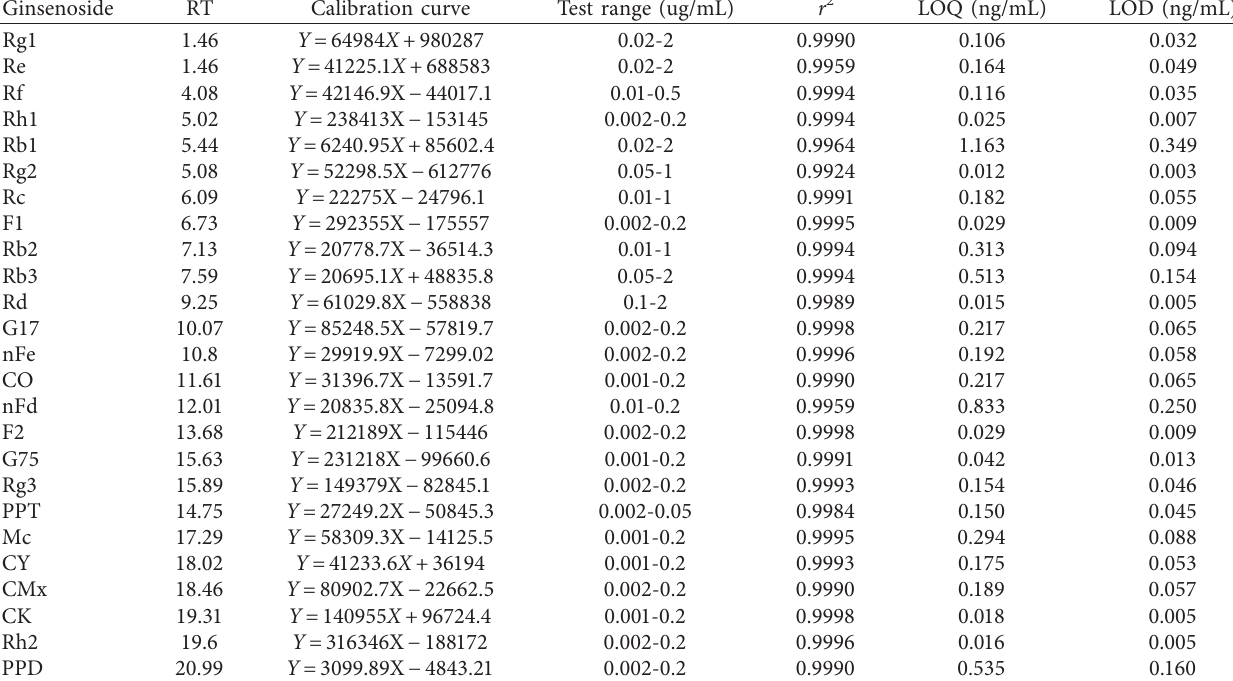
Table 1: Calibration curves, limit of quantification (LOQ), and limit of detection (LOD) of UPLC-MS methods for determination of 25 ginsenosides.